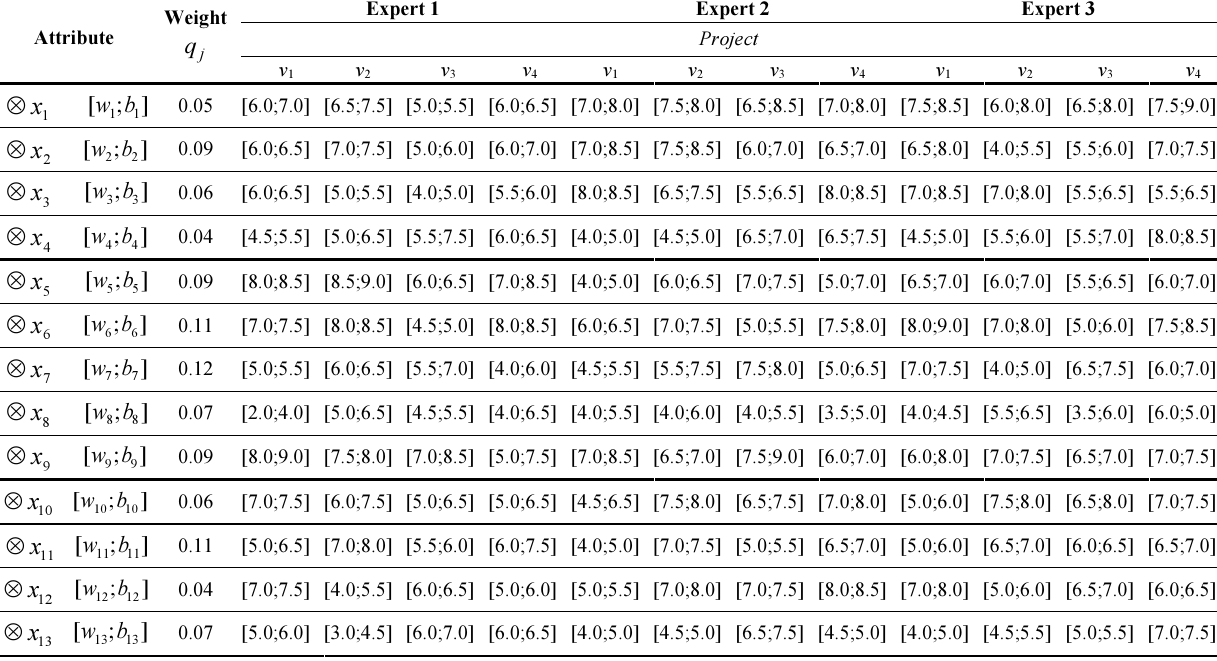
Table 1. Initial decision-making matrix with values at some intervals